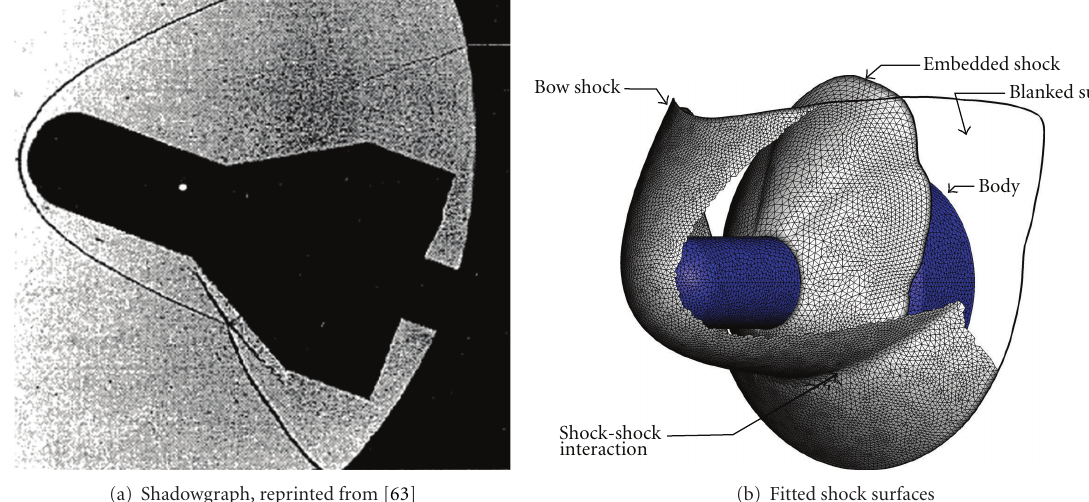
Figure 11: Supersonic ( M ∞ = 4 . 04) flow past a cylinder with conical